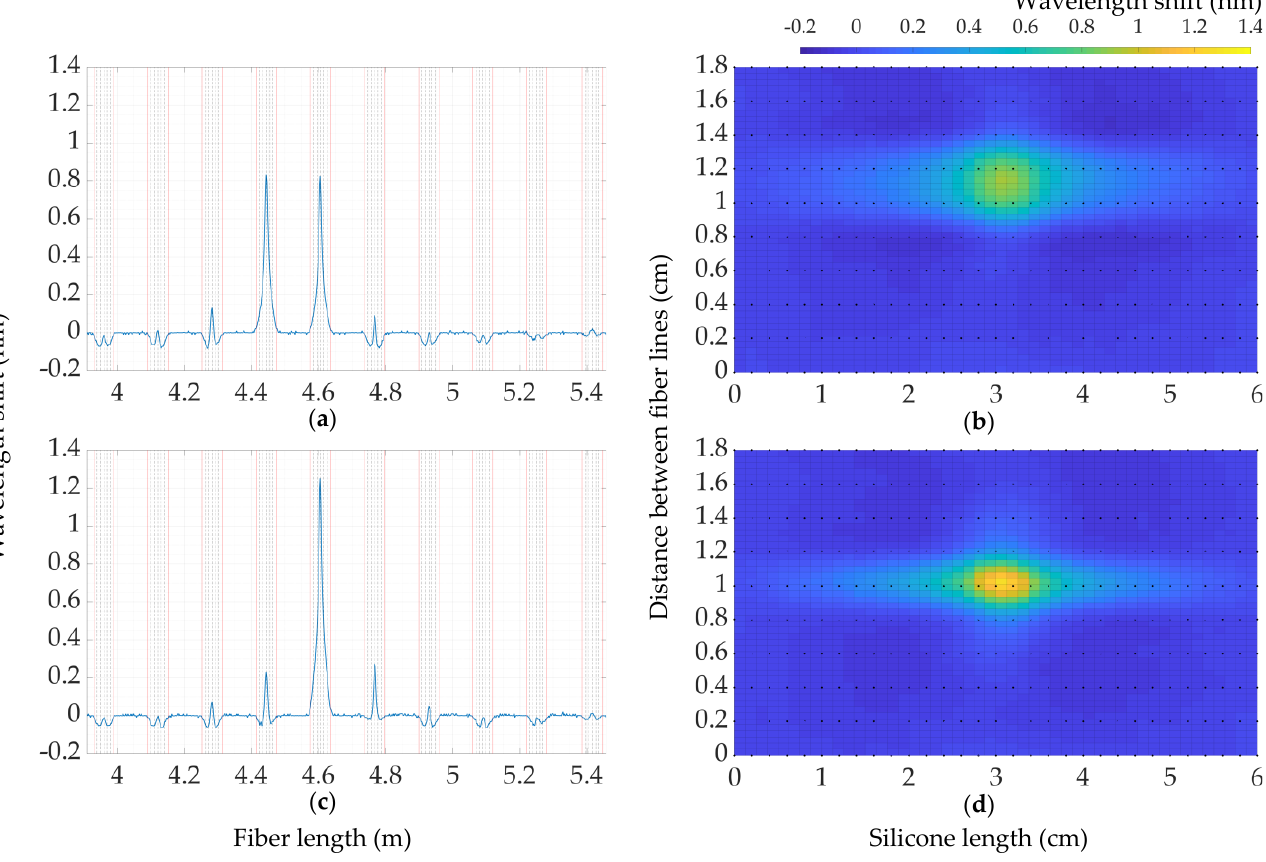
Figure 10. The distribution of a wavelength shift along the fiber on the points “C8” ( a,b ) and “C9” ( c,d ) for 900 g.